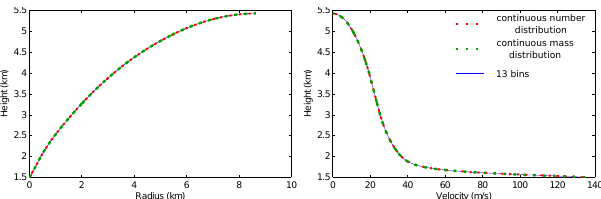
Figure 4. Height vs. radius (left) and velocity (right) for a low-flux plume, simulated with three different models. In blue the profiles obtained using 13 bins, in red the profiles obtained using a continu- ous distribution of the particle number density and in green using a continuous distribution of the mass fraction.